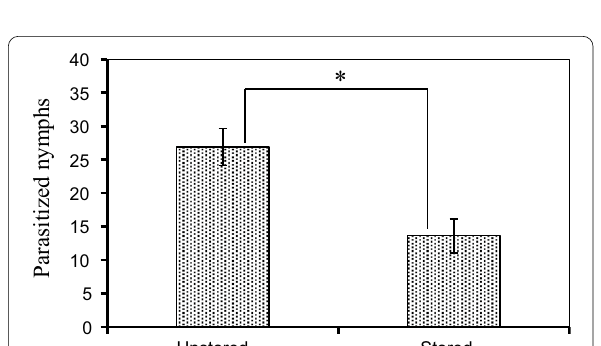
Fig. 2 The total mean ( SE) number of immature Bemisia tabaci ± parasitized by Eretmocerus mundus females obtained from unstored and eight-day-stored E . mundus pupae. The asterisk indicates significant difference based on t test ( P < 0.05)